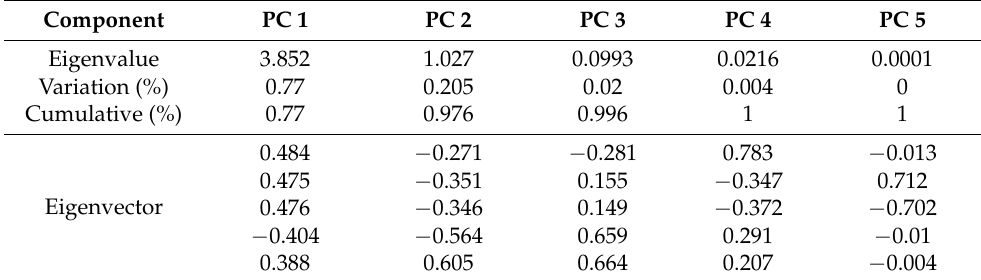
Table 8. Principal component